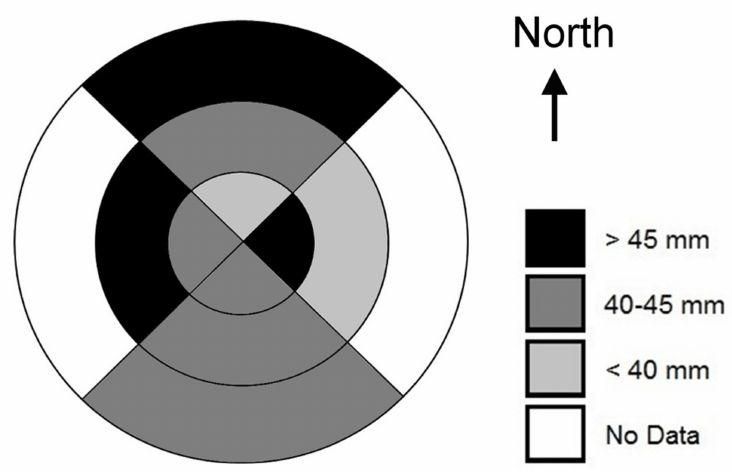
Figure 4. Mean 2016 root collar diameter of seedlings planted in ungraded plots, by slope position and aspect. The center of the diagram corresponds to the top of a mound.